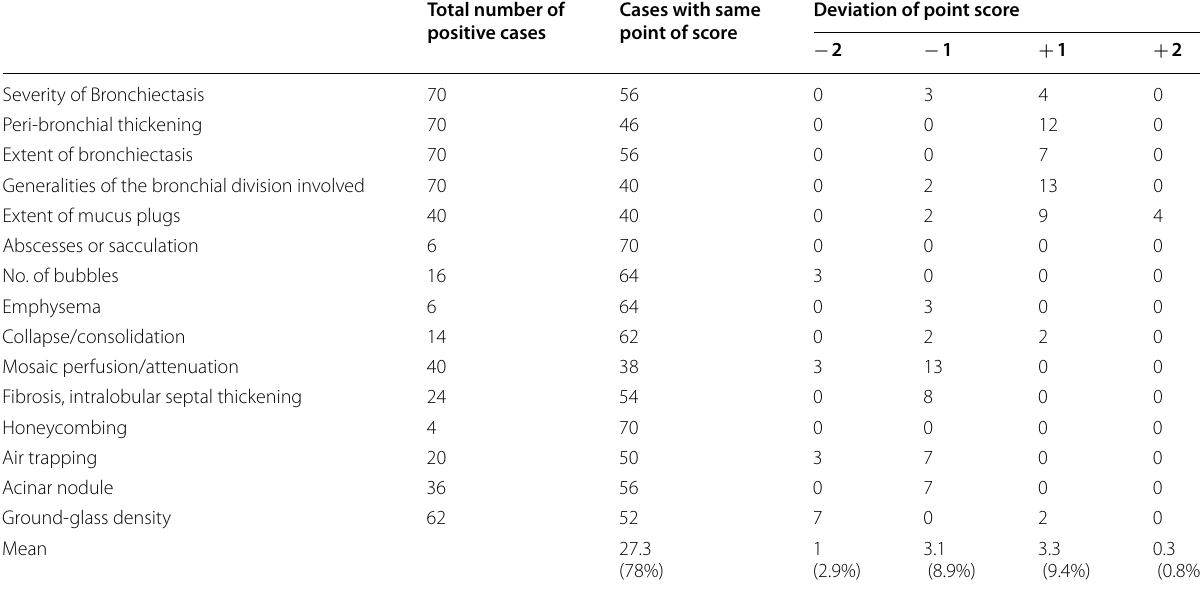
Table 1 The individual agreement and deviation points of scores